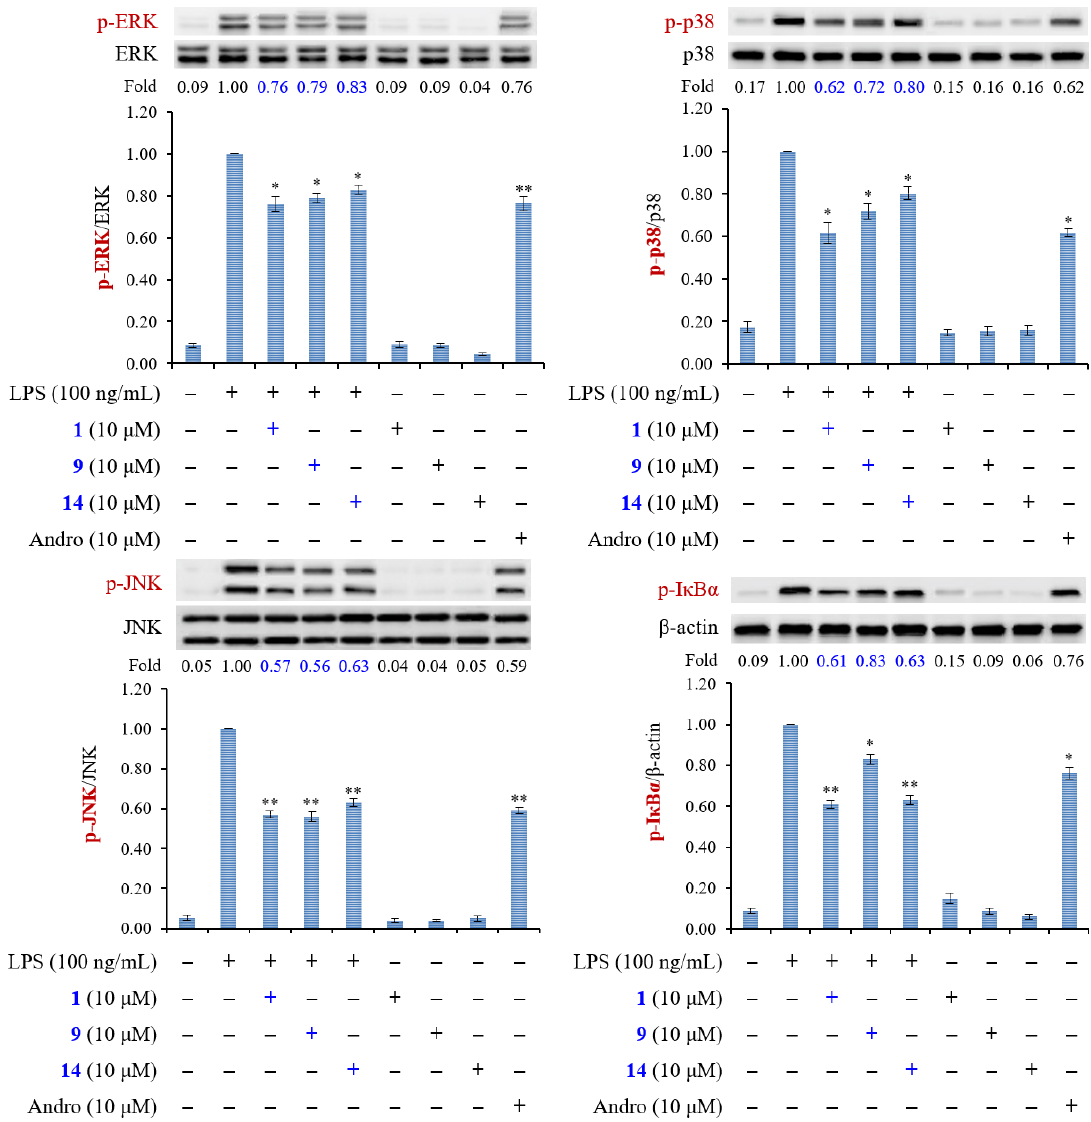
Figure 6. Compounds 1 , 9 , and 14 inhibit the phosphorylation of MAPKs and IκBα in LPS-activated macrophages. RAW264.7 cells were pretreated with 1 , 9 , and 14 (10 μM) for 6 h, and then stimulated with LPS for 15 min. Phosphorylation of MAPKs and IκBα was analyzed by immunoblotting. Densitometric analysis of all samples was normalized to the corresponding total protein or β-actin. Andrographolide (Andro) was used as positive control. Results are displayed as mean ± SEM of three independent experiments. “+” means treatment with LPS or compound. “−” means no treatment with LPS or compound. Asterisks indicate significant differences (* p < 0.05 and ** p < 0.01) compared with the control.